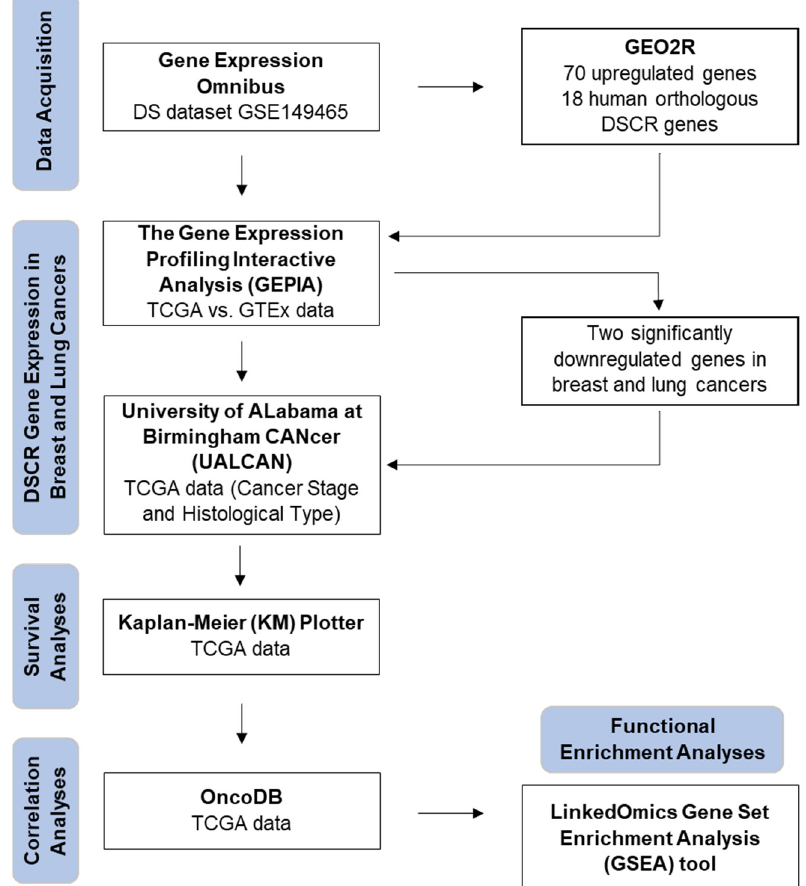
Figure 1. Flow diagram of bioinformatics approach used in study.